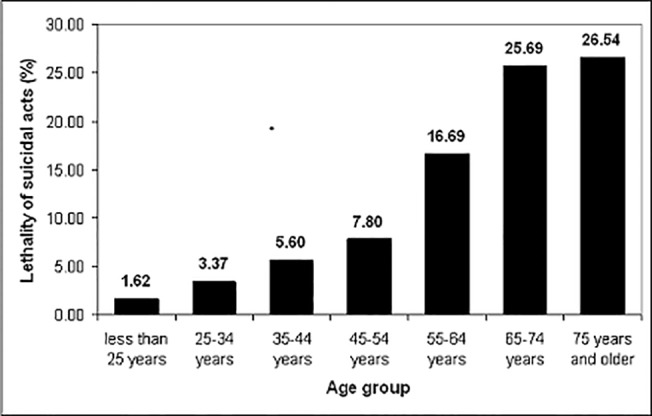
Lethality of suicidal acts in seven age groups.